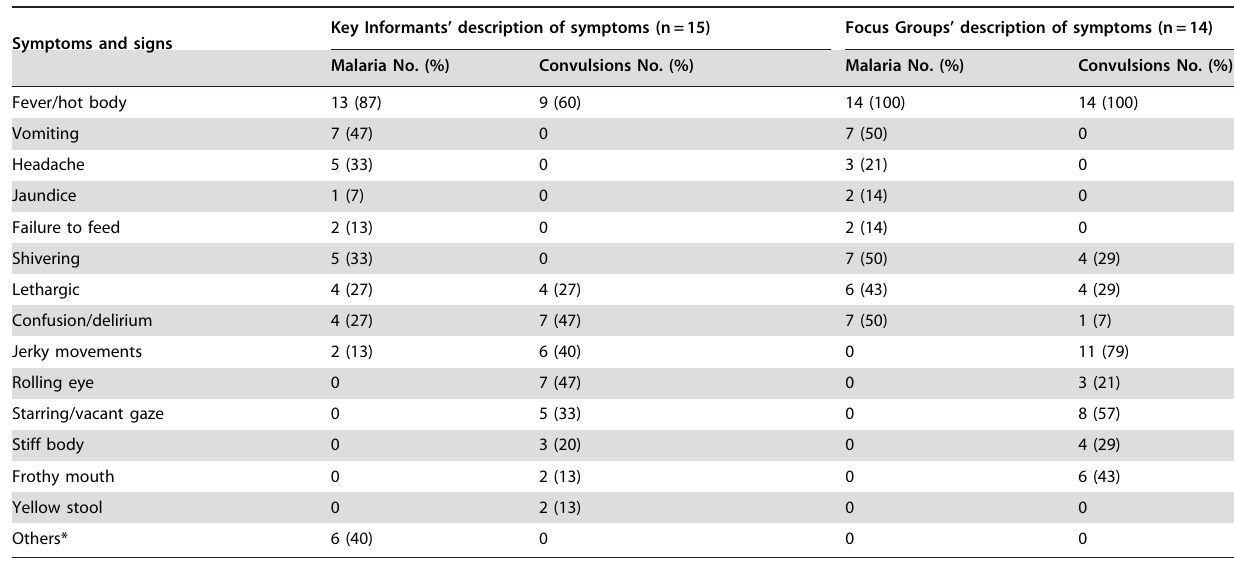
kuchemka , sometimes as hot abdomen ( tumbo kuwaka joto kali ) or hot with very high fevers attributed to other illnesses, particularly to those associated with evil spirits or witchcraft. Through the head ( kichwa joto ) with many informants also mentioning chills monthly community surveys of underfive morbidity, a total of and/or shivering ( kutetemeka ). A few stated that relatively mild 1054 fever episodes were reported among the 1099 under-five raised temperatures were normally interpreted as a sign of malaria, Table 4. Key Informants’ and Focus Groups’ description on symptoms and signs of malaria and convulsions, leading cause of